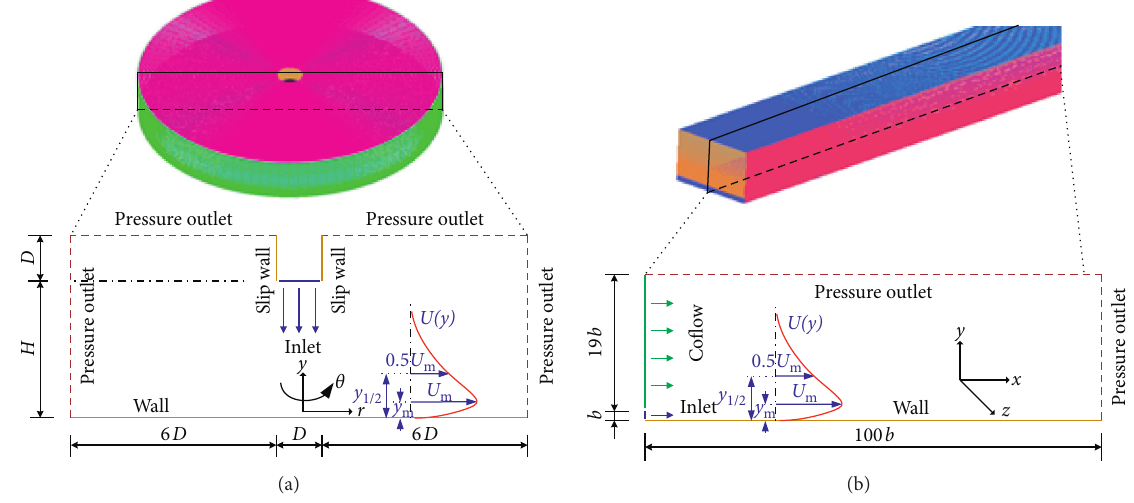
Figure 1: Computational domains and grids for radial and plane wall jets. (a) Radial wall jet. (b) Plane wall jet.